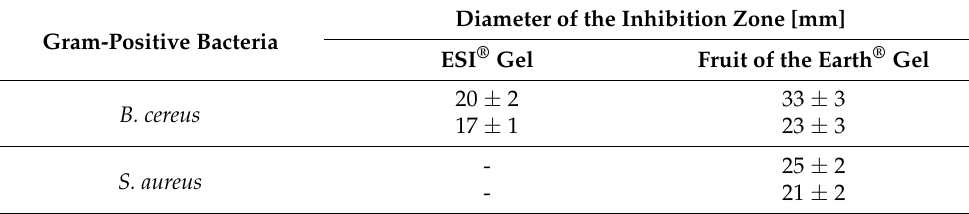
All data are expressed as mean ± standard